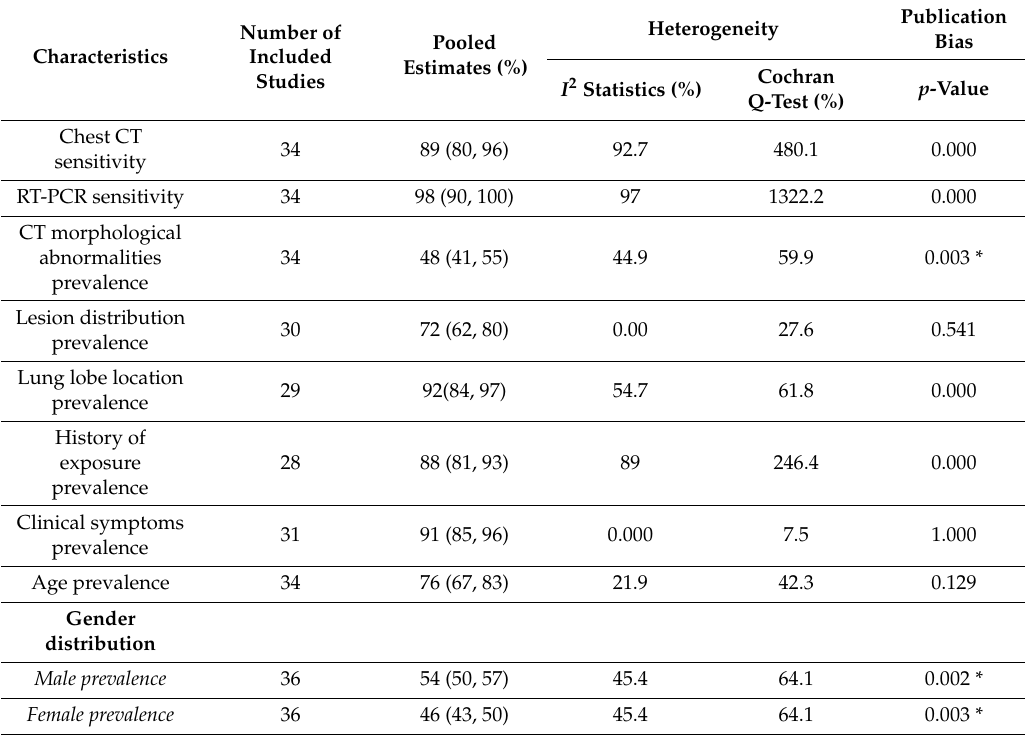
Table 4. Summary of meta-regression analysis for diagnostic sensitivity of chest CT and pooled prevalence of other parameters.